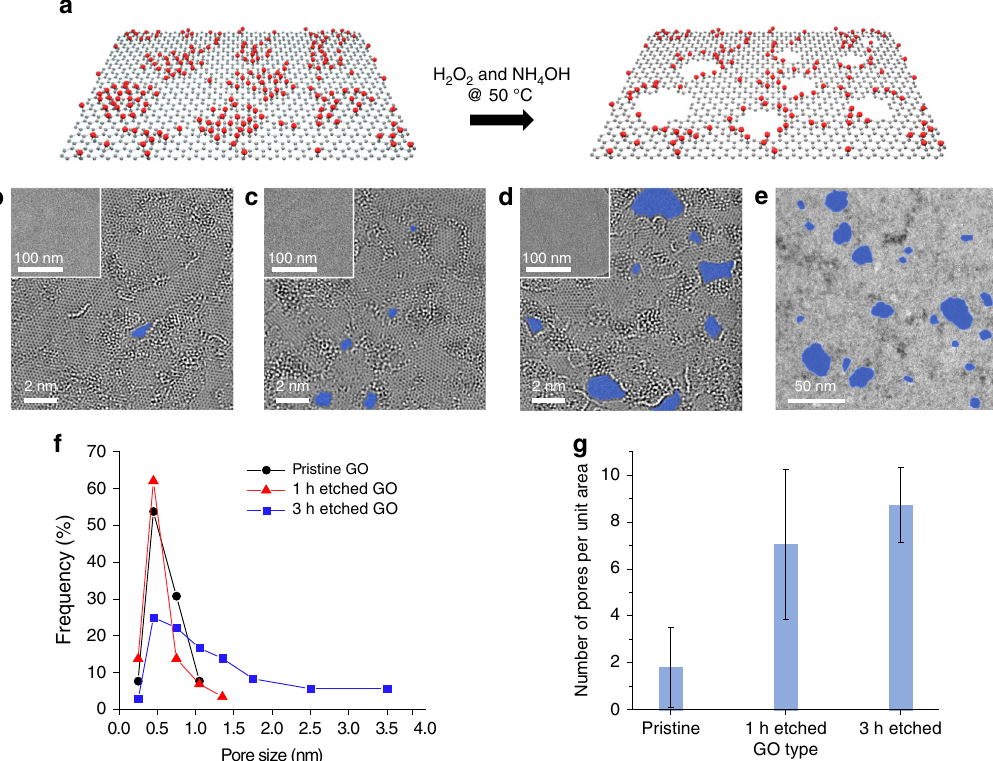
Fig. 1 Controlled oxidative etching of GO yields single layers with tunable porosity. a Schematic models of GO and porous GO. Red dots represent sites with oxygen-containing functional groups, which are preferentially etched, leaving holes on the graphene sheet. HR-TEM images of GO sheets b before and after being etched for c 1 h, and d 3 h, respectively. Pores are highlighted in blue color. The corresponding lower-magni fi cation TEM images are shown in the insets. e A low-magni fi cation TEM image of the 5-h-etched GO sample, showing extensive formation of large pores. f Size distribution and g number density of pores found on the starting and etched GO sheets, based on a survey over an area of 500 nm 2 in HR-TEM images. Error bars represent the standard deviation (SD)